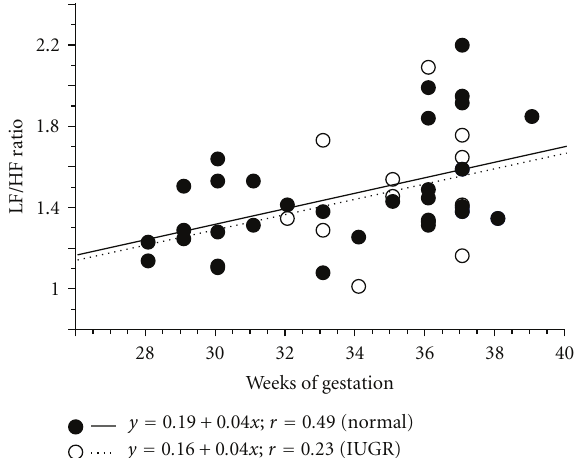
y = 0 . 19 + 0 . 04 x ; r = 0 . 49 (normal) y = 0 . 16 + 0 . 04 x ; r = 0 . 23 Figure 6: Correlation between the low frequency/high frequency (LF/HF) ratio and gestational age in normal pregnancy and IUGR. (Normal pregnancy, • —; IUGR, ◦ ... ).